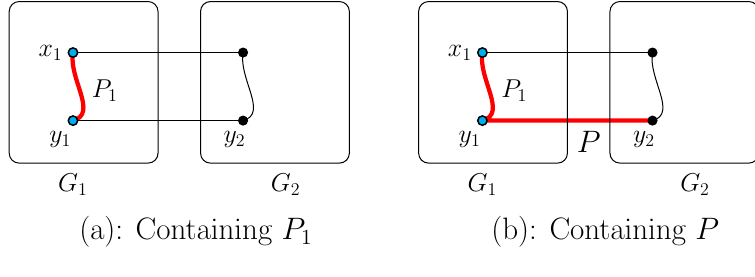
Figure 8: Geodesic (2 d +